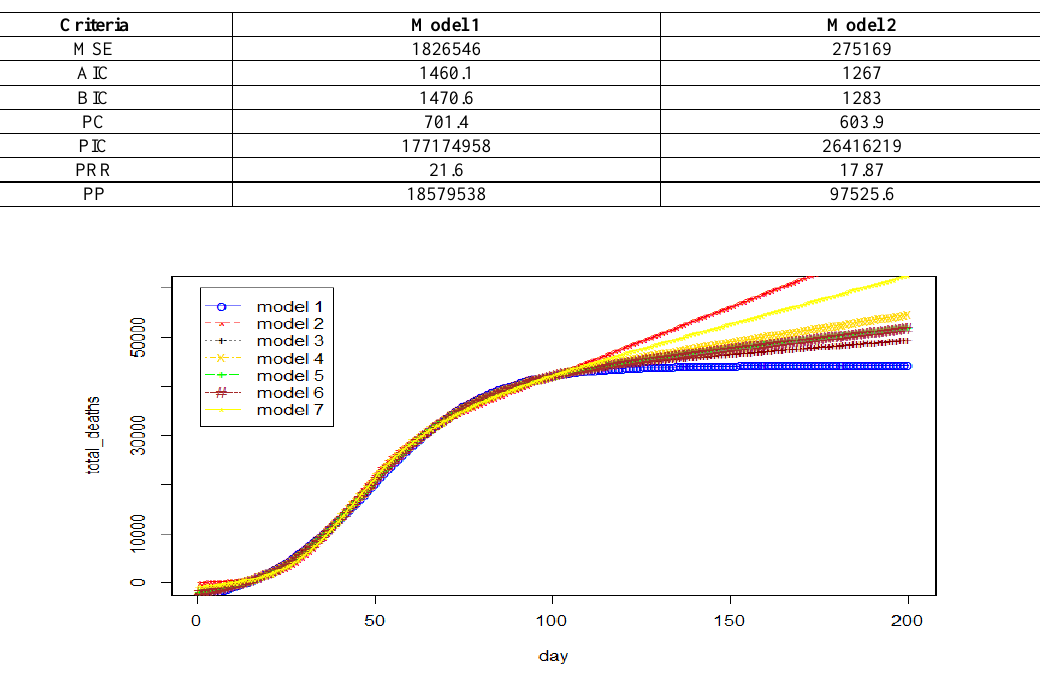
Figure 10. The estimated cumulative number of deaths vs day in the United Kingdom (UK)